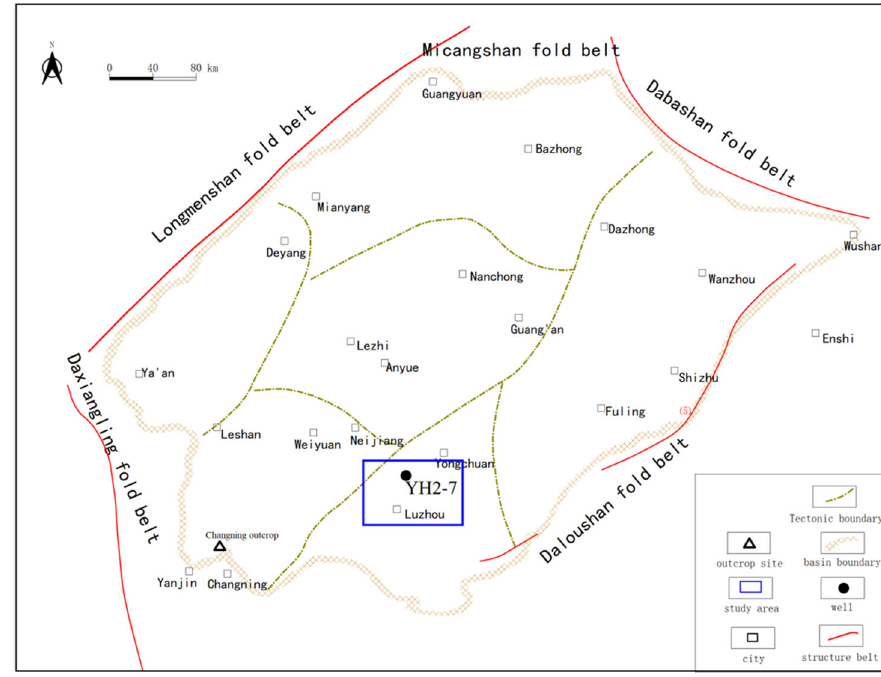
Figure 1. Location map of the Luzhou block [30].